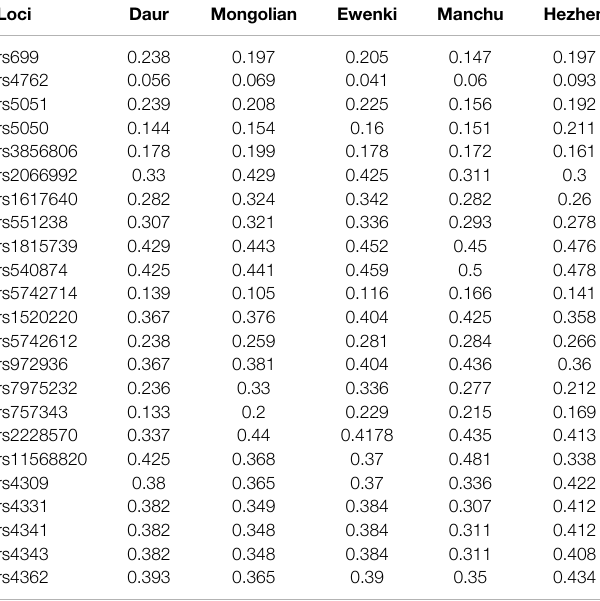
TABLE 2 | The minimum allele frequencies of 23 SNPs in fi ve